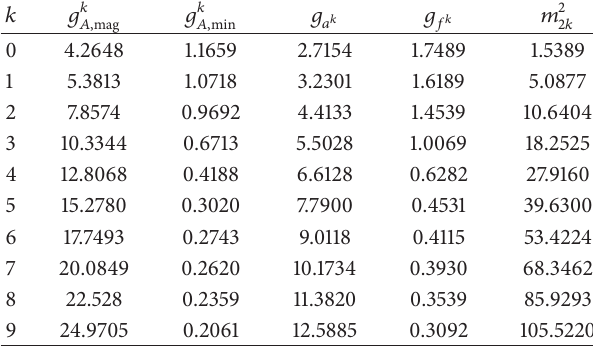
Table 6: Numerical results of axial-vector meson couplings to the nucleon for the ten lowest mesons using the AdS 6 model. Meson masses are in the 𝑀 KK